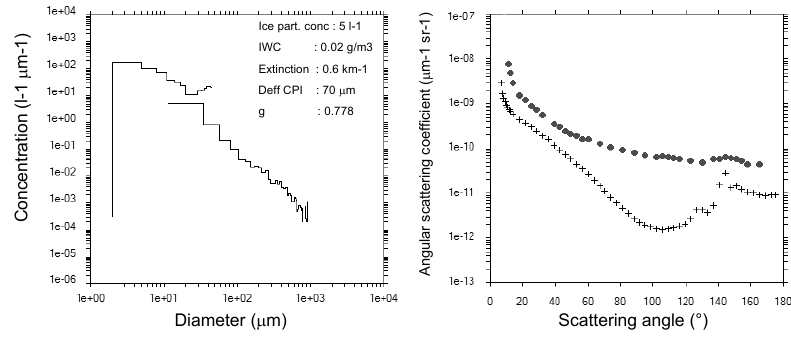
Fig. 4b. Ice water-phase cloud properties. Right panel: Mean scattering phase function measured by the Polar Nephelometer (circle symbols) and scattering phase function obtained by Mie theory (cross symbols) calculated with the average droplet size distribution measured by the FSSP-100 over the same time-period. Left panel: FSSP-100 and CPI size-distributions. Are also reported the mean values of the pertinent microphysical and optical parameters (Concentration of ice particles with D> 100 µ m, IWC: ice water content, extinction coefficient, Deff: effective diameter, g : asymmetry parameter).